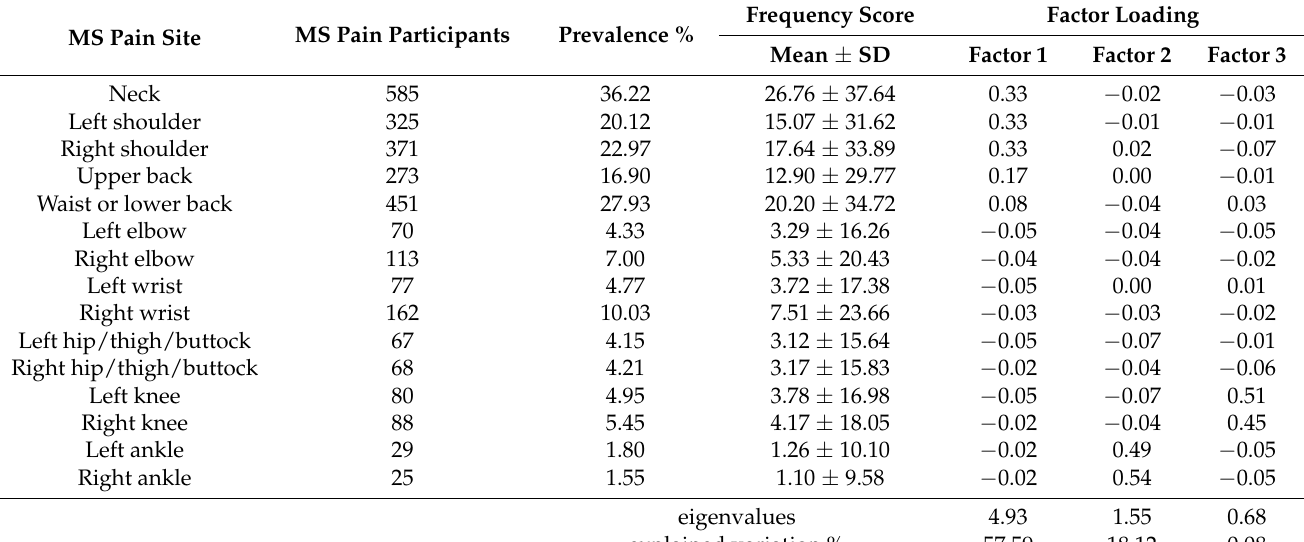
Table 1. MS pain sites and factor analysis of the Nordic musculoskeletal